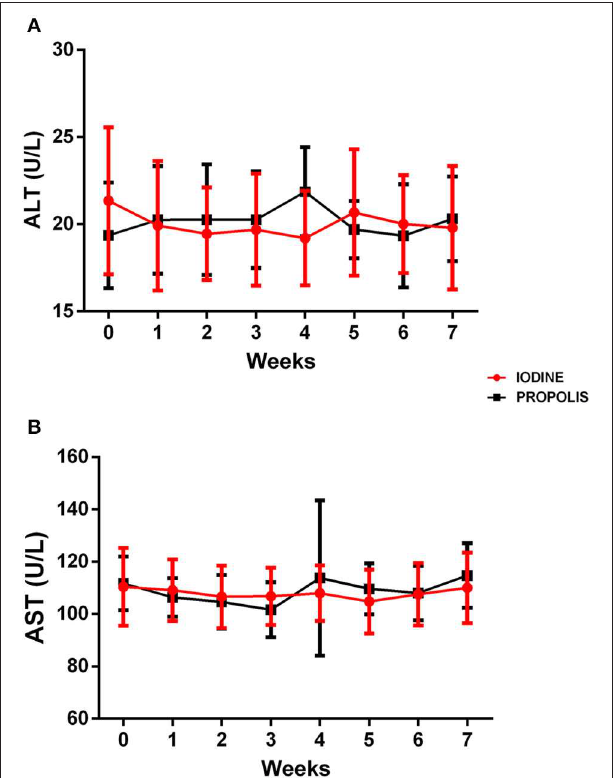
FIGURE 6 | Determination of ALT (A) and AST (B) levels in animals of the two experimental groups throughout the observation period. Results are presented as mean of each observation time for each group, and bars indicate their respective standard deviations. There were no significant statistical differences between the groups when the Student t -test ( p < 0.05) was used to compare the mean of each group at a given